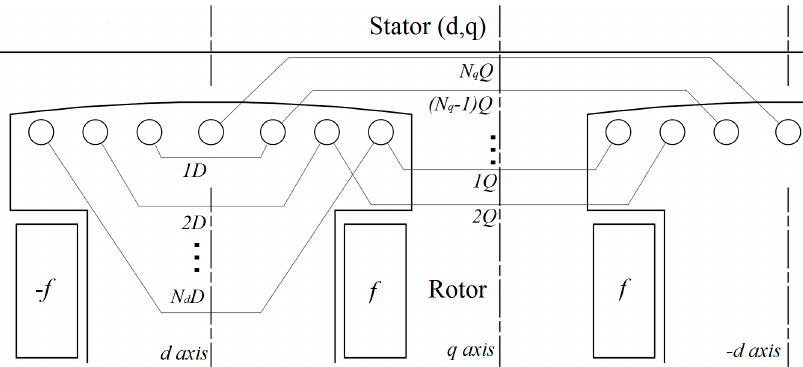
Figure 1. Schematic of the salient-pole synchronous machine (SPSM) model. 1D … N d D and 1Q … N q Q are the concentrated coils of the kD and kQ windings of one pole, respectively. f is the field winding.